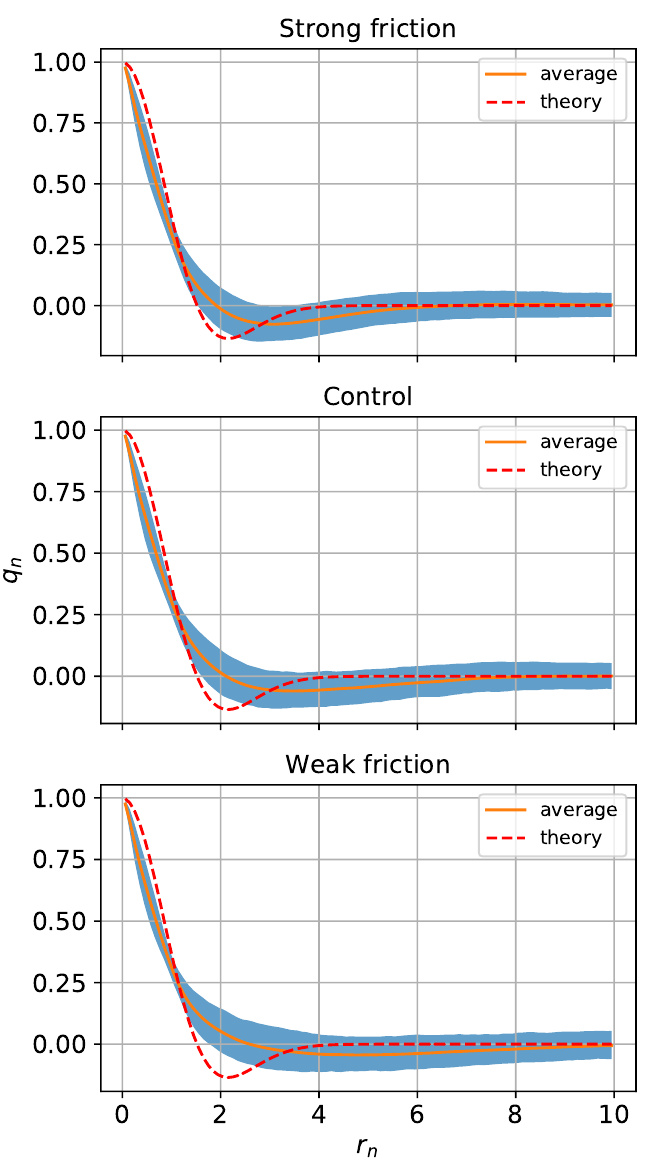
Figure 8. Mean radial structure of PV in coherent eddies. Panels from top to bottom are from the strong, control and weak friction cases. The orange solid curve is the PV normalized by its maximum value in the eddy center and averaged over all the coherent eddies. The blue shading spans the 20th–80th percentiles of the normalized PV at each radial distance normalized by the e-folding scale of the PV distribution. The red dashed line is the theoretical radial structure given by (11) and is normalized by its own e-folding